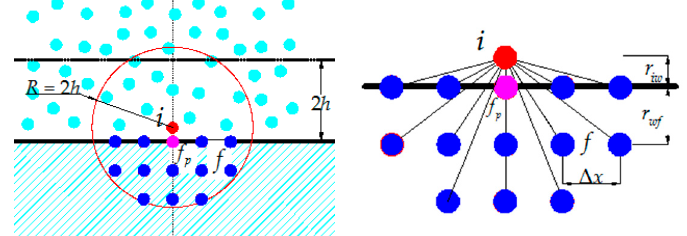
Figure 3. Fictitious particles generation mechanism of the local semi-fixed ghost particles method for a fluid particle near the wall boundary.